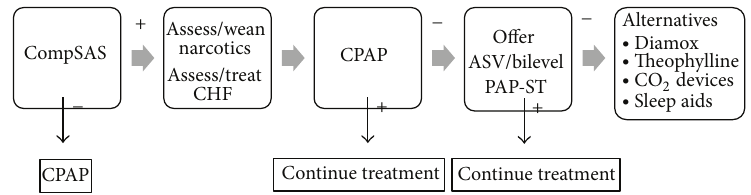
Figure 4: A schematic representation of treatment modalities of complex sleep